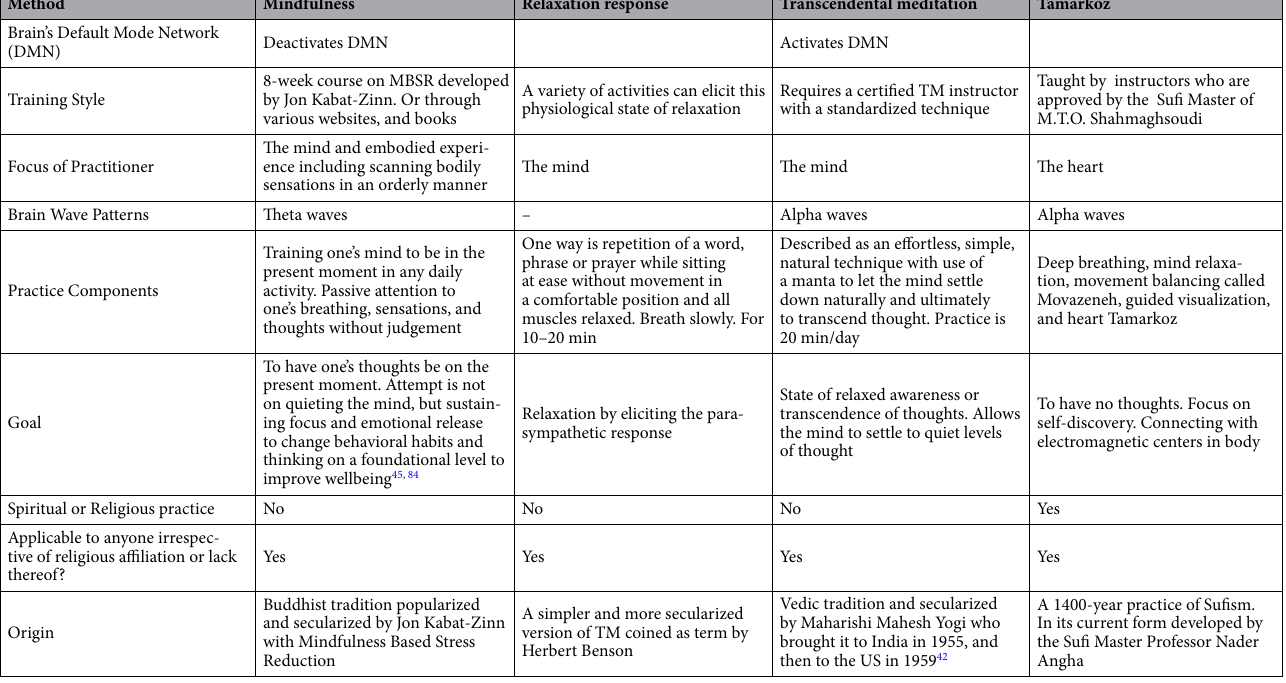
Table 1. Comparison of meditation